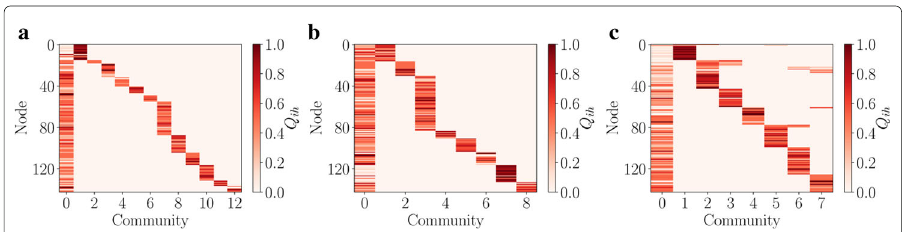
Fig. 11 Results of our parameter identification method on the Enron email corpus case study. Matrix Q is estimated, starting from the community structure detected by using ( a ) Infomap, ( b ) Louvain, and ( c ) OSLOM